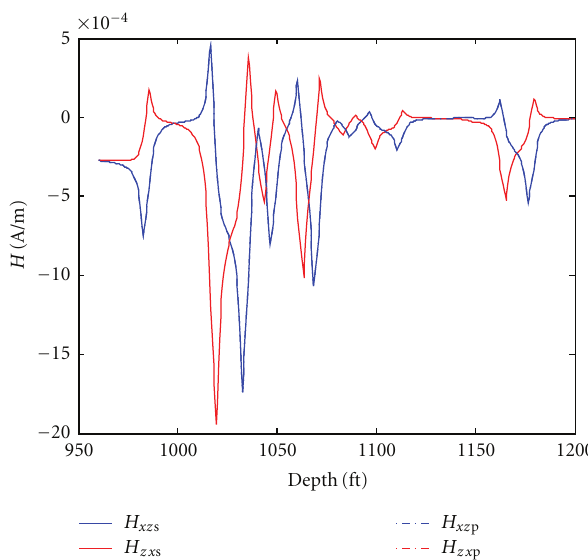
Figure 16: Comparison of cross components (1000 points) from the serialized and parallelized codes.